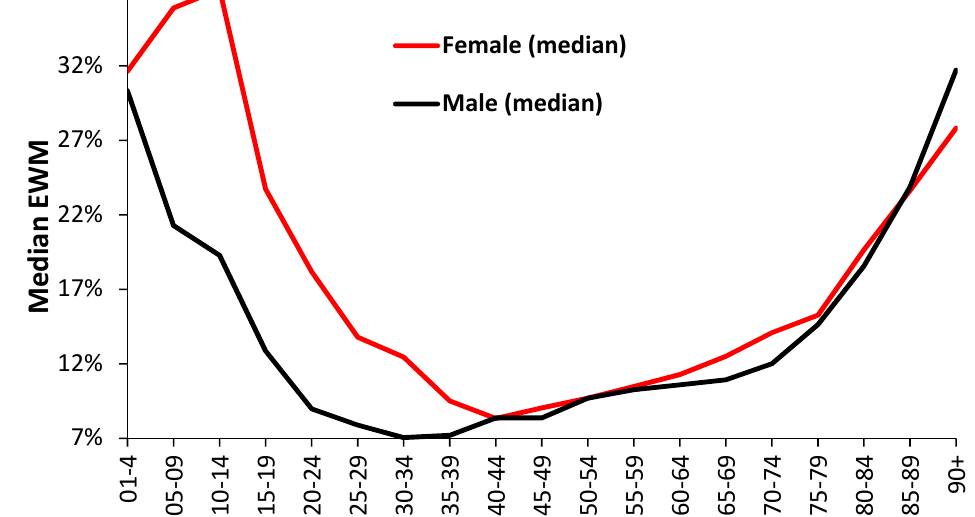
Figure 4. Median value of EWM (1993/94 to 2015/16) for males and females by age band. However, dynamic analysis shows a far more complex set of age-gender relation- ships, shown in Figure 5. The magnitude of the gender difference is constantly changing with time for each age band; hence, age 70–74 reaches a maximum gap of 7% in March 2007, while age band 85–89 reaches a 7% difference in March 1997. The apparent lower EWM for males aged 90+ in Figure 4 comes from a run of low male EWM from 2004 to 2010, which is not seen in other years. Further age-specific peaks occur each winter.